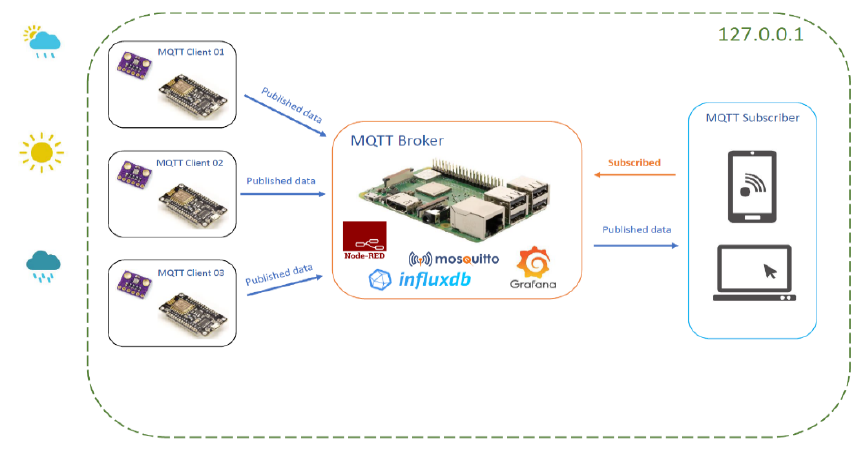
Figure 3. System concept, own study A. Wycisk.